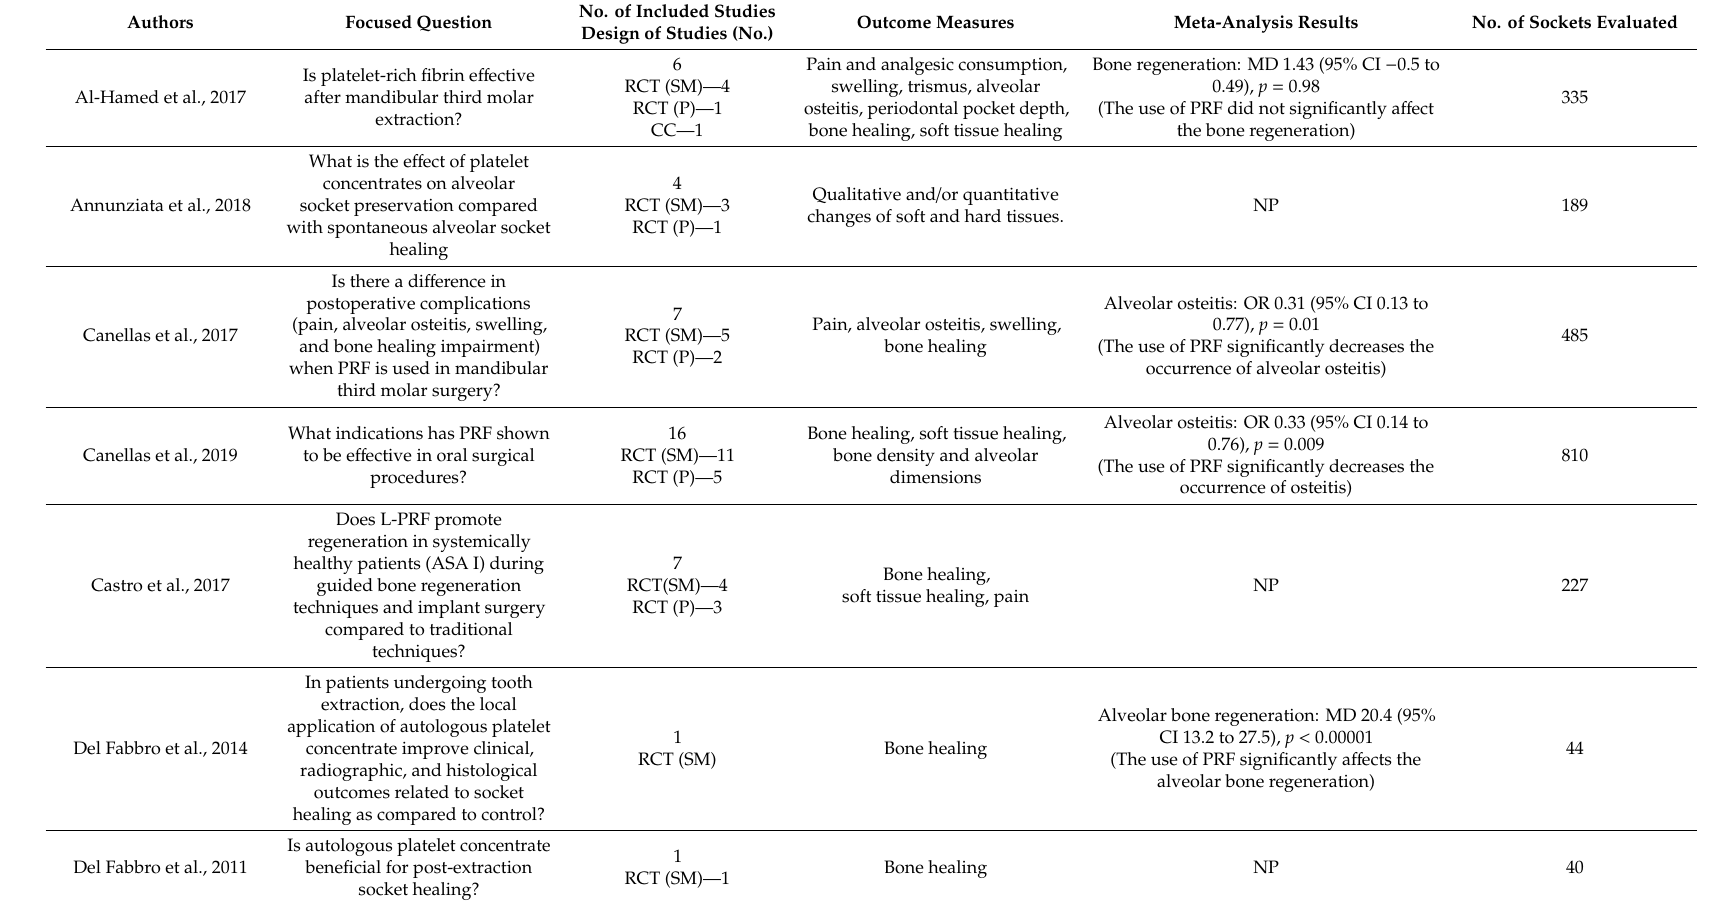
Table 1. Main characteristics of included